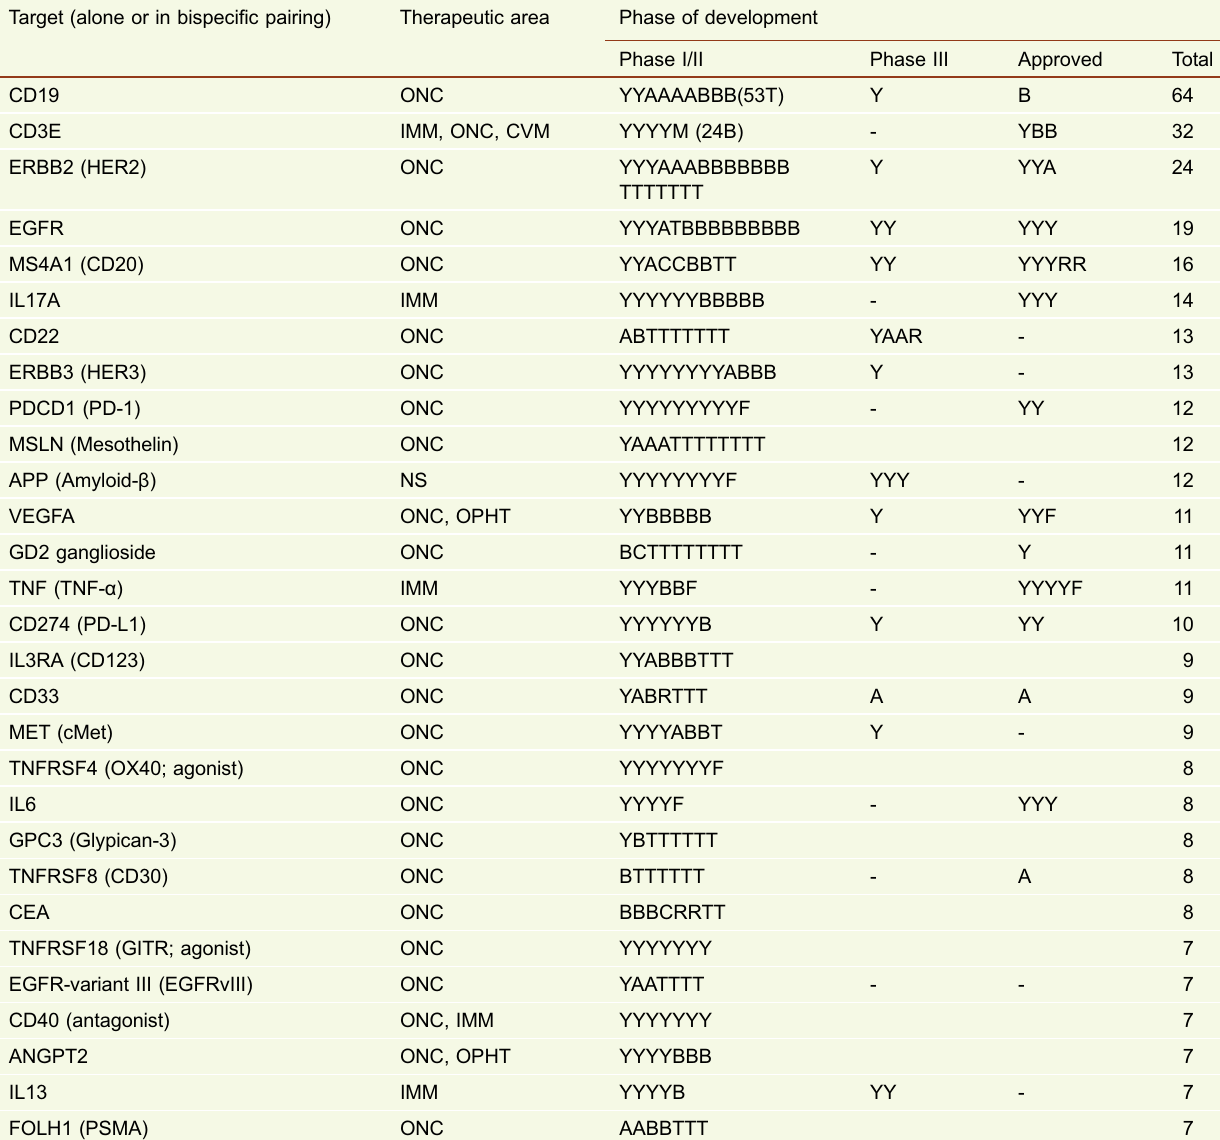
Table 6. Top targets based on number of molecules developed towards them Target (alone or in bispeci fi c